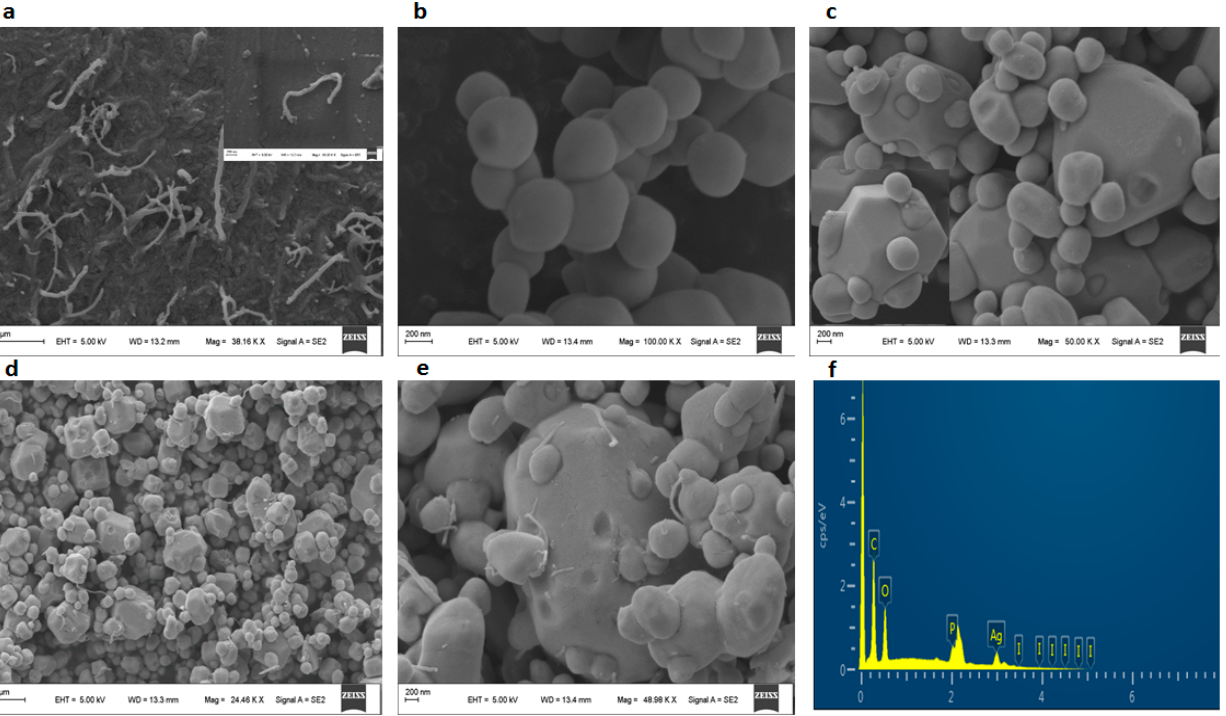
Figure 3. SEM image of ( a ) CNT-COOH, ( b ) Ag 3 PO 4 , ( c ) Ag 3 PO 4 @AgIO 4 , ( d ) CNT/Ag 3 PO 4 @AgIO 4 , ( e ) CNT-COO − /Ag 3 PO 4 @AgIO 4 , ( f ) EDS analysis of CNT-COO − /Ag 3 PO 4 @AgIO 4 .